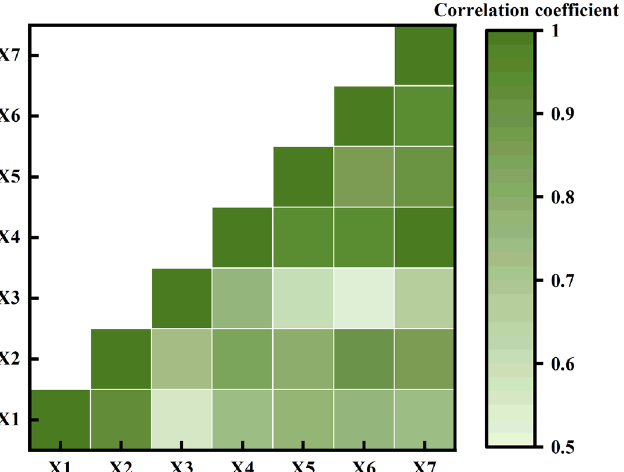
Figure 3. Spearman correlation coefficients between pollutant emissions and major pollutants in surface water.